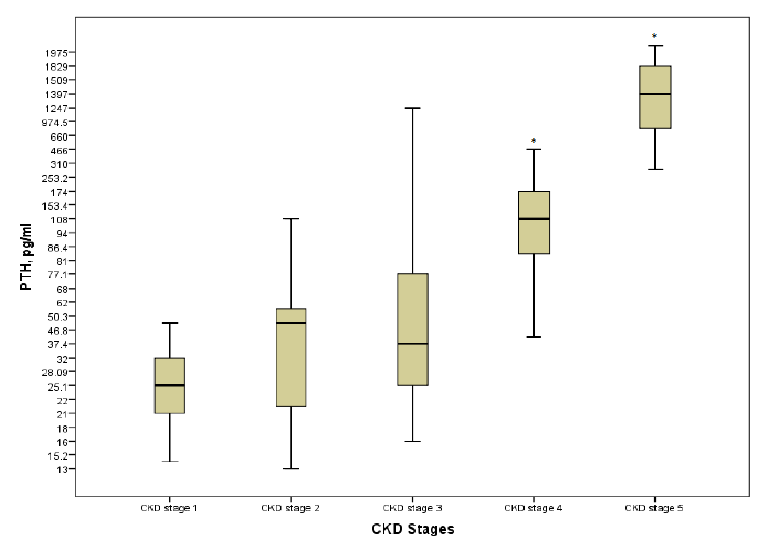
Figure 4. PTH level in the various CKD stages. * p = 0.000 CKD stages 4 and 5 vs. CKD stage1. There were 23 (31.51%) children with a normal range of 25-OH vitamin D, 15 (20.55%) children suffered from vitamin D insufficiency, and 35 children (47.94%) had a deficiency of vitamin D. There was no significant association of 25-OH vitamin D with kidney func- tion decline ( p = 0.145). 3.4. Correlations of FGF-23 with Other Bone Markers As it is displayed in Figure 5, the elevated level of FGF-23 went ahead hyperphos- phatemia and elevated PTH. The elevated FGF-23 was noticed in 7.1% of children with CKD stage 1. The same number of patients had increased indices of serum phosphate. It was remarkable that more than 50% of children with CKD stage 2 had the elevating level of serum FGF-23, and that index became increasing with the disease progression and it achieved 100% at the dialysis stage. Serum phosphate increased more slowly, and it was revealed only in 57.1% and 70.6% of children with CKD stage 4 and stage 5, respectively. About 7% of patients with stage 2 had elevated PTH. However, PTH increased more pro- gressively and it was identified in 100% of the dialysis patients as well as FGF-23. Figure 5. Proportion of study population with the elevated phosphate, PTH and FGF-23 in serum across all CKD stages (%). There was a strong positive correlation between phosphaturic hormone and PTH ( r = 0.807, p = 0.000), as well as a moderate positive correlation with phosphate ( r = 0.473, p = 0.000) (Figure 6). In opposite, FGF-23 level is inversely correlated with calcium, ionized calcium, and 25-OH vitamin D ( r = −0.36, p = 0.002; r = −0.3, p = 0.009; r = −0.33, p = 0.004, respectively). The correlation was slightly weak.